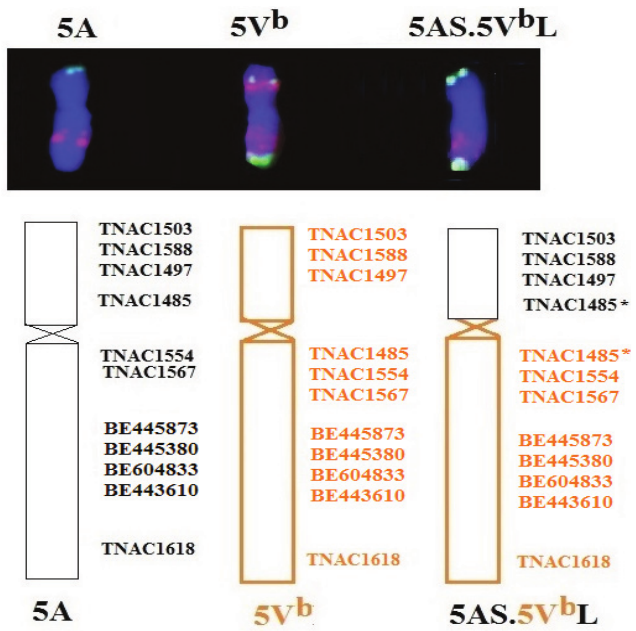
Figure 5. FISH karyotypes and molecular markers distributed on chromosomes 5A, 5V b , and 5AS.5V b L translocation. The stars indicates the duplicated markers on chromosome 5AS.5V b L.